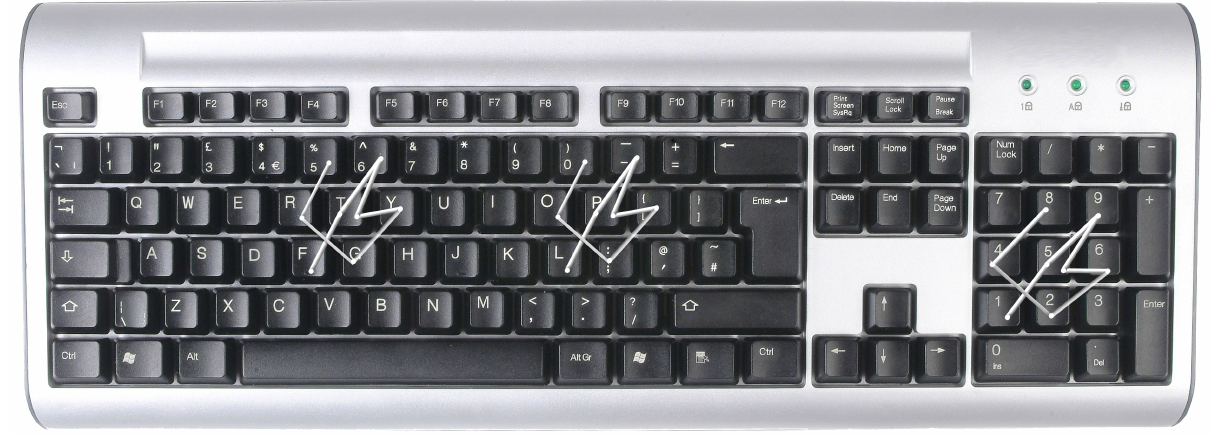
Figure 1. The same sequence to generate different passwords (about 15 minutes to memorize the sequence).